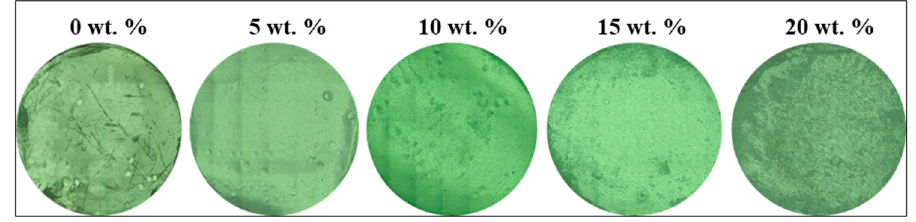
Figure 2. Laser microscope images of CA/AlN composites.